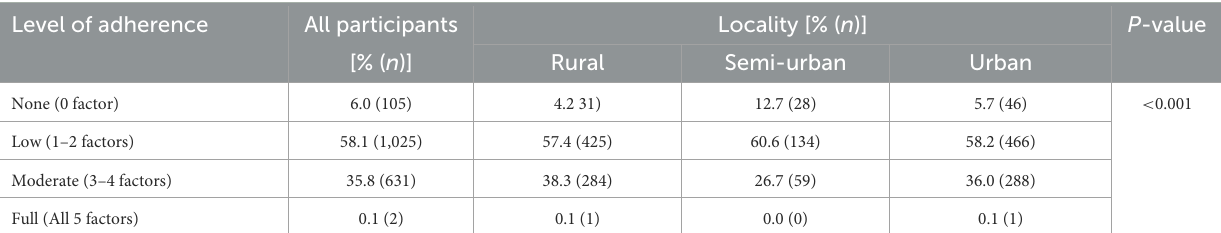
TABLE 5 Level of adherence to malaria control measures in Cameroon ( n =